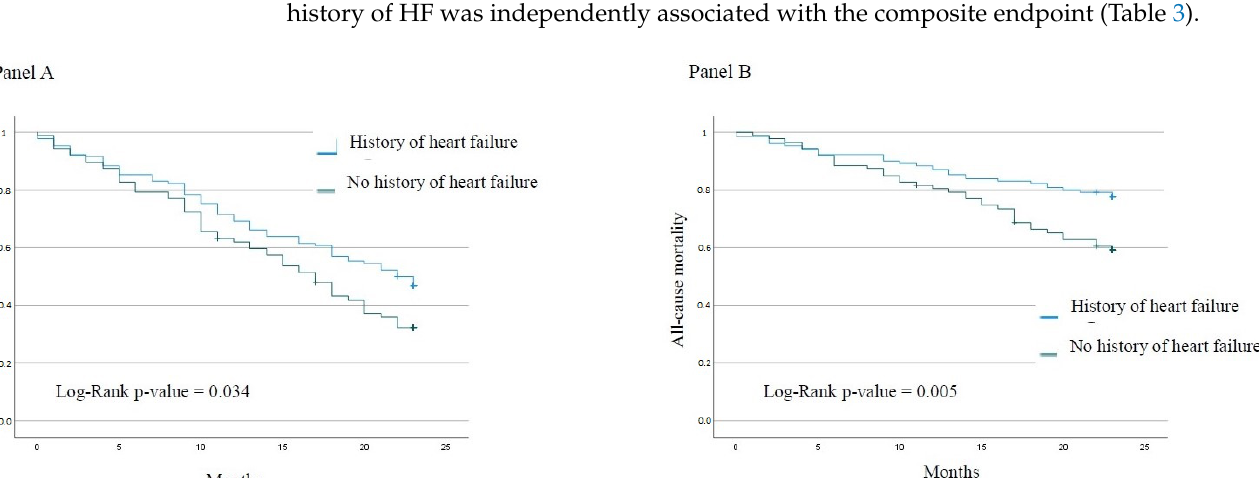
Table 2. Outcomes of patients with heart failure at inclusion compared to those without HF.